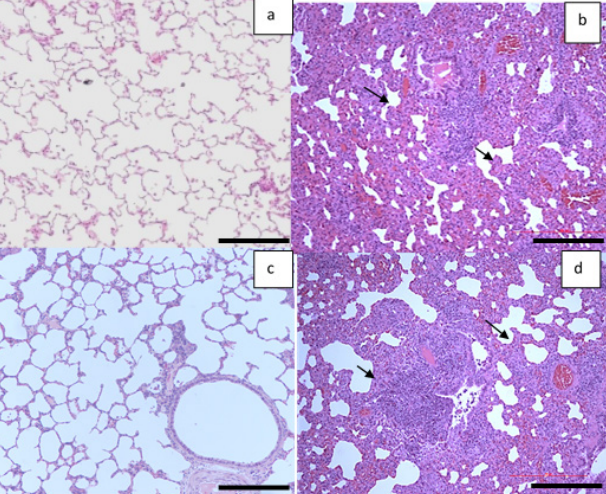
Figure 6. a. Rabbit lung, negative control (group 14). The septa and the alveoli conserve the normal morphology of the organ without thickening or detritus, respectively. H&E, 10X. b. Rabbit lung, positive control (group 13). Severe thickening of the alveolar septa is evident due to the presence of inflammatory infiltrates; multifocal congestion is also evident. H&E, 10X. c. Rabbit lung treated with P. multocida and GlcNAc (group 1). There is only one focus of slight thickening of the alveolar septa (arrow). H&E, 10X. d. Rabbit lung treated with P. multocida + GalNAc (group 4). The observed changes are similar to those in the panel of positive control (7 b ). Severe thickening of the alveolar septa is evident due to the presence of inflammatory infiltrates, as well as multifocal congestion. H&E, 10X. Scale bar: 200